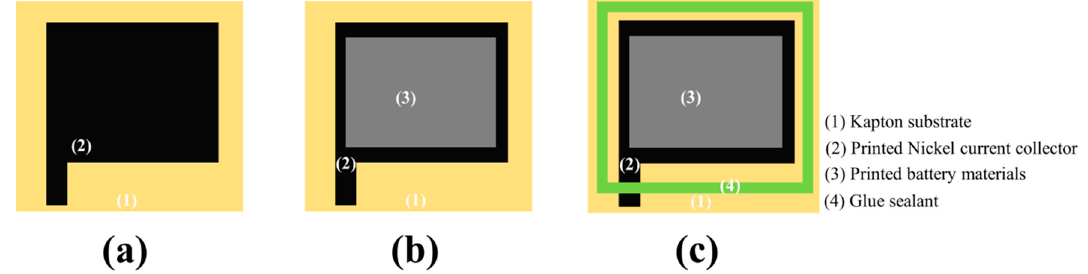
Figure 3. Schematics of printed cathode and anode: step ( a ) nickel current collector; step ( b ) battery materials (cathode and anode materials) are printed on the nickel current collector; step ( c ) glue sealant is applied.